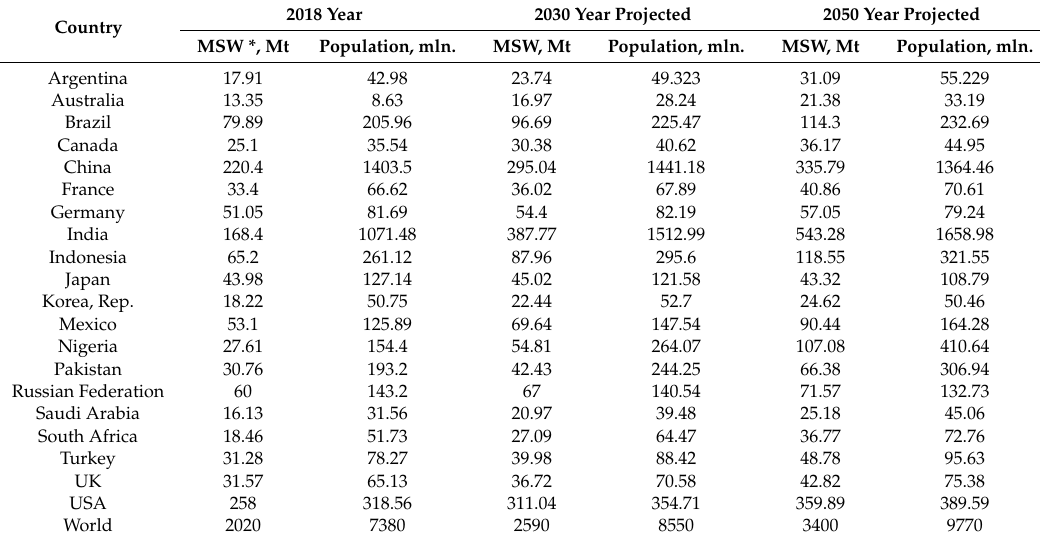
Table 1. Waste generation and projections by country